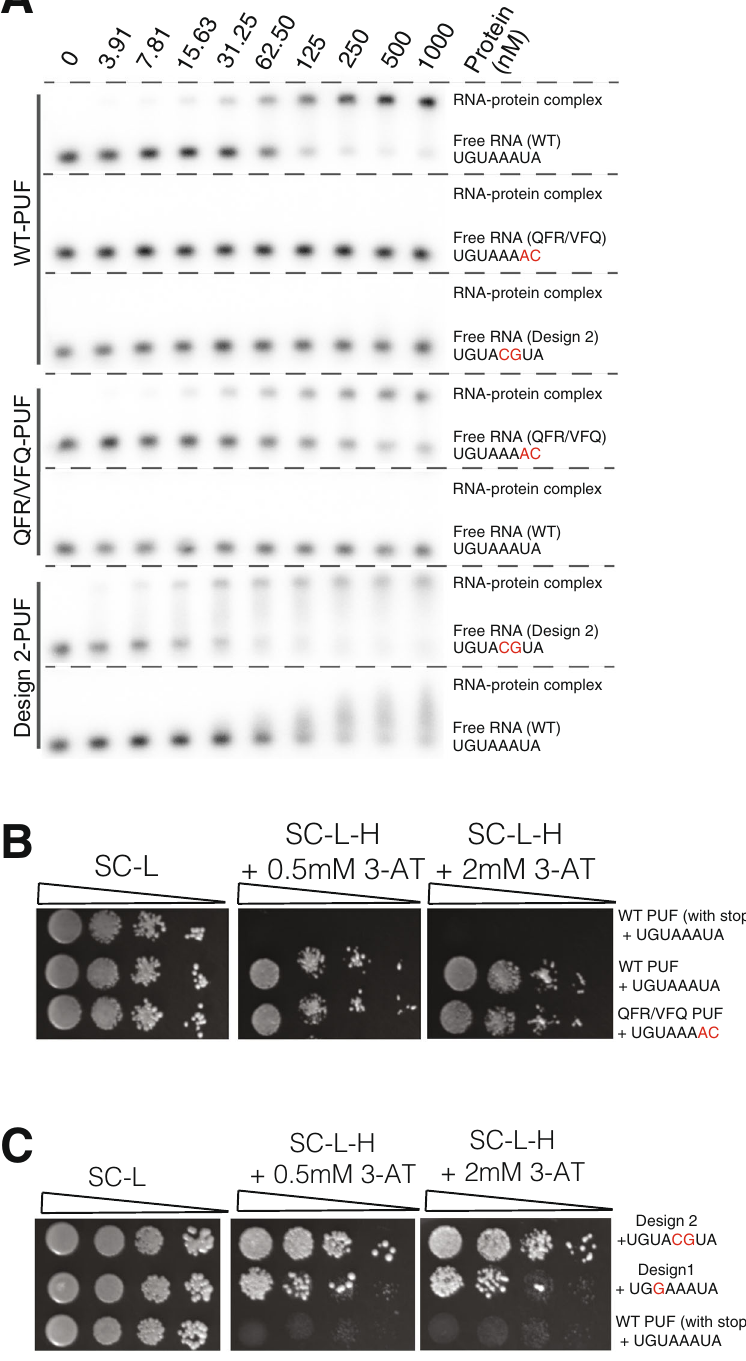
Fig. 7 Electrophoretic mobility shift assays and three-hybrid assays for wild-type and variant PUF domains. A Electrophoretic mobility shift assays show the in vitro binding for the wild-type PUF domain, the QFR/VFQ PUF variant, and the design 2 variant to the wild-type RNA sequence or an RNA containing mutated bases. Results are representative of two biological replicates. B Yeast three-hybrid assays show the binding of the wild-type PUF domain and QFR/VFQ variant. The negative control is a wild-type PUF domain that has stop codons in the TRM locations (repeat 1) paired with wild-type RNA. SC-L, synthetic complete media minus leucine; SC-L-H, synthetic complete media minus leucine and histidine. C Spot dilution plate assay indicates the binding of the design 1 and design 2 PUF domains to their target RNAs. The negative control is as in ( B ). The starting OD600 that was spotted was 0.05, with three sequential 10-fold serial dilutions